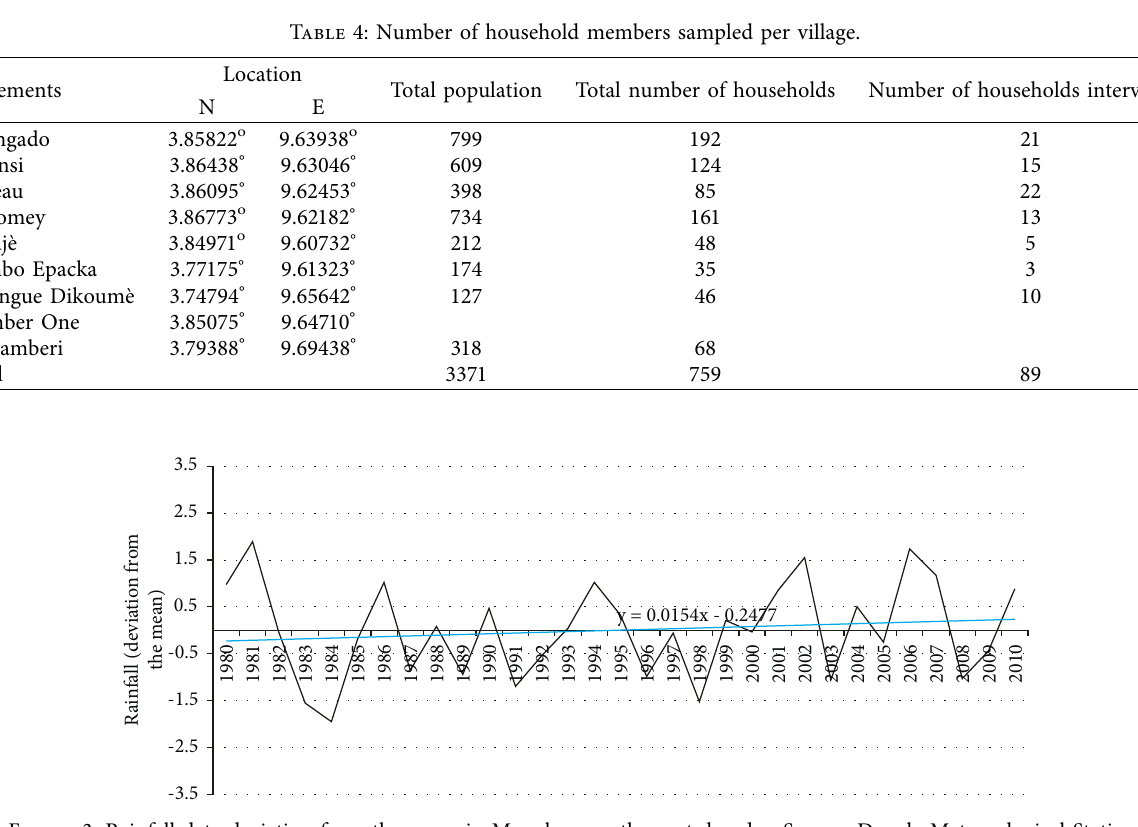
Figure 3: Rainfall data deviation from the mean in Manoka over the past decades. Source: Douala Meteorological